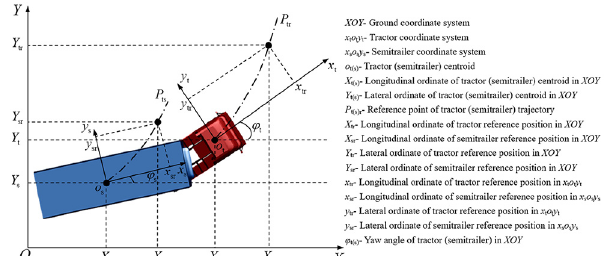
Figure 1 Illustration of articulated truck plane motion and trajectory reference